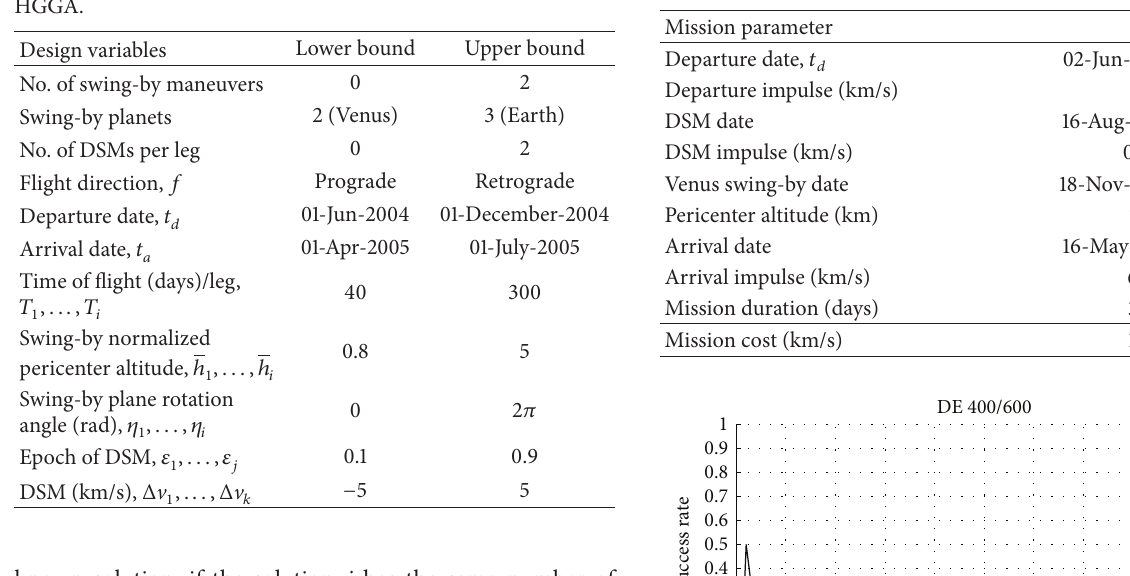
Table 3: Solution trajectory for the Earth-Mars mission.